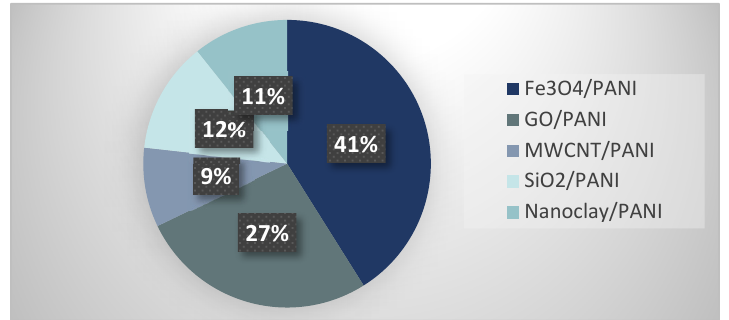
Figure 6. Publication statistics related to different PANI nanocomposites used for the adsorption of metal ions, based on reviewed articles.